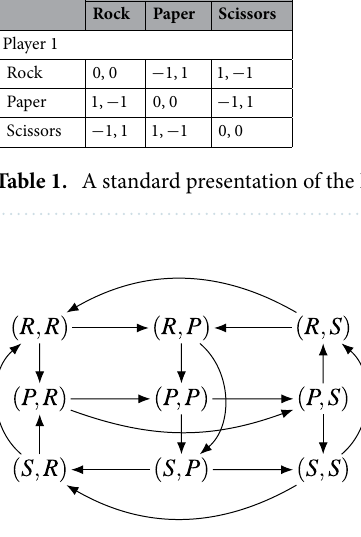
Figure 1. The response graph of